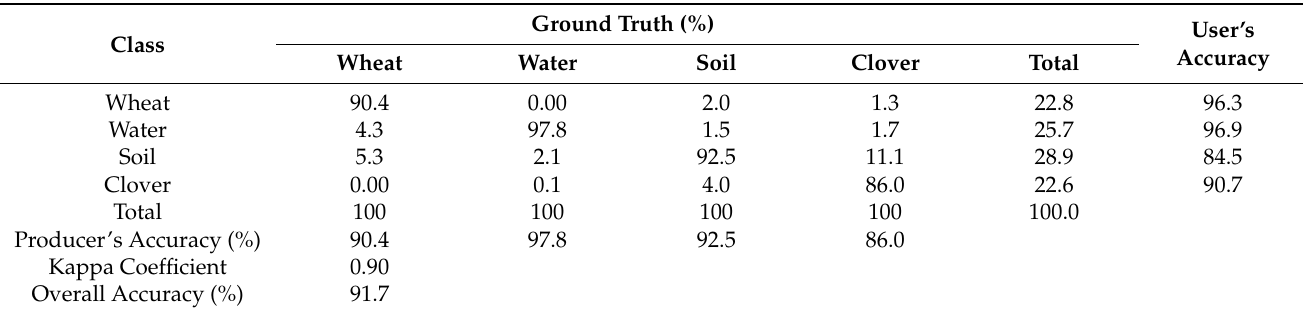
Table 4. Outputs of confusion matrix for MLC of wheat and other classes in the south-west Nile Delta, Egypt.